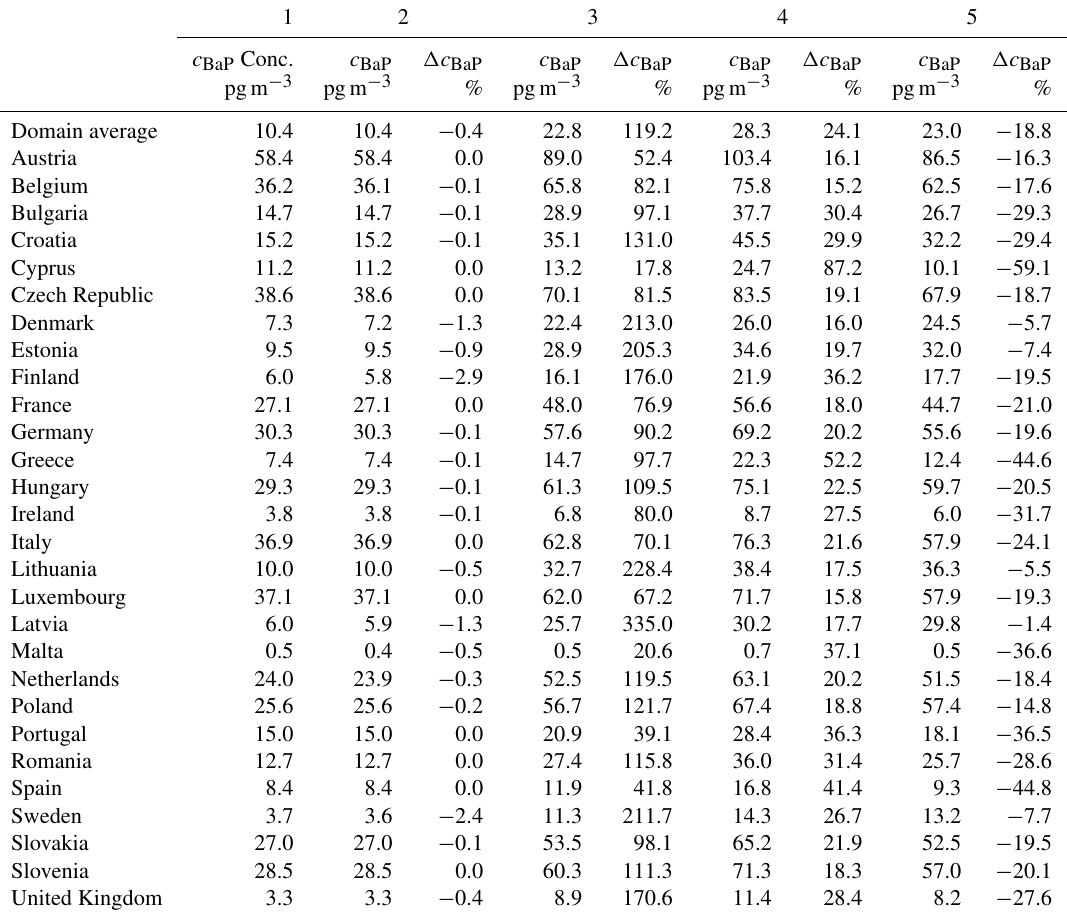
Table 3. Average ground-level BaP concentrations, c BaP (pgm − 3 ) over the entire domain and in individual 28 EU member states for all simulated scenarios and concentration changes (cid:49)c BaP (%) between subsequent